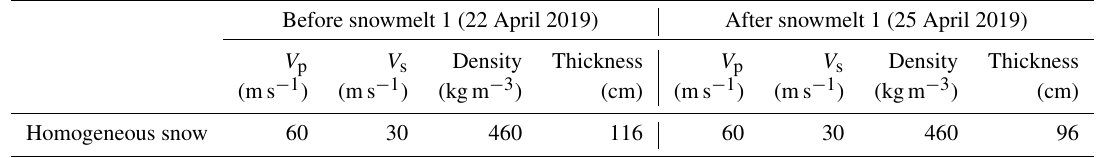
Table 5. Values of the snow model for snowmelt 1